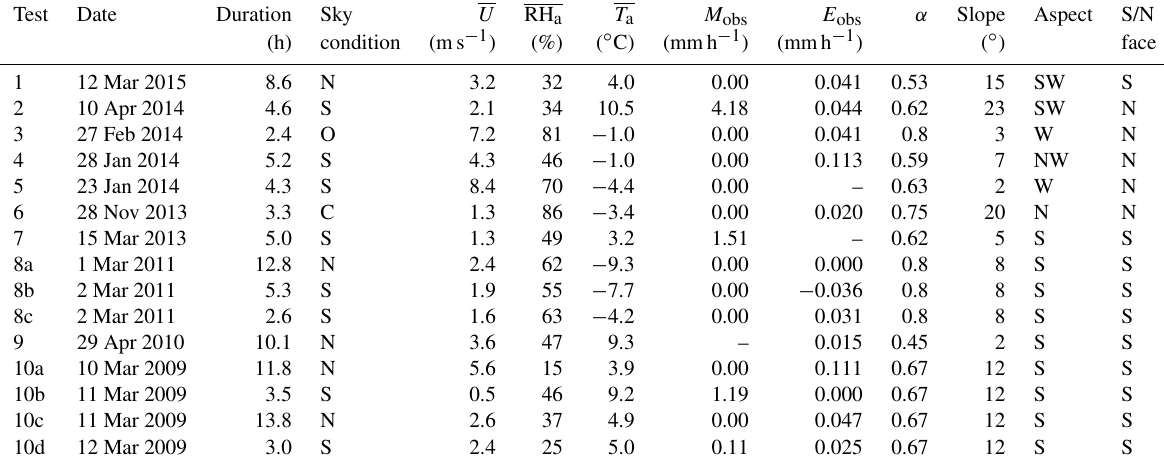
Table 3. Summary of the 15 data sets extracted from the 10 field campaigns with their date, duration, sky condition (N, night; S, sunny; O, overcast; C, cloudy), main weather drivers (wind speed, U ; relative humidity, RH a ; air temperature, T a ), measured evaposublimation ( E obs ) and melting ( M obs ) rates, measured snow albedo ( α ), and main topographic features of the test sites.